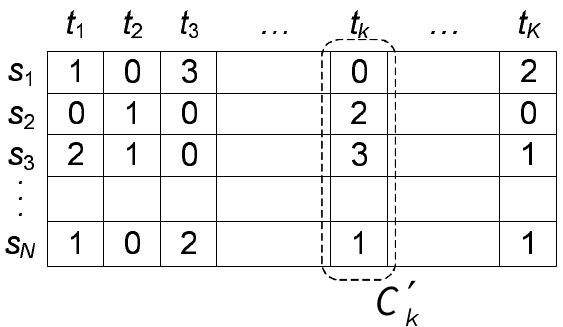
Figure 3. Chromosome